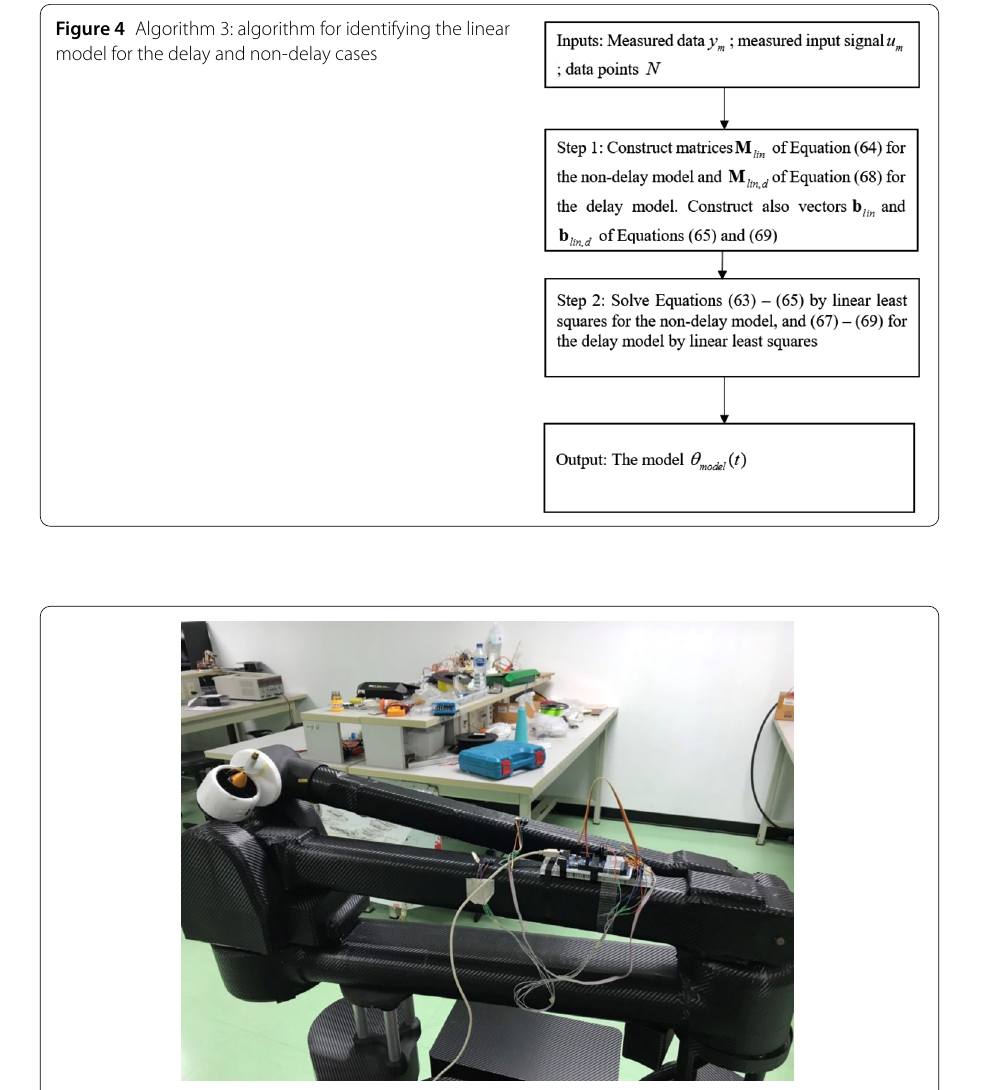
Figure 5 The schematic of the arm